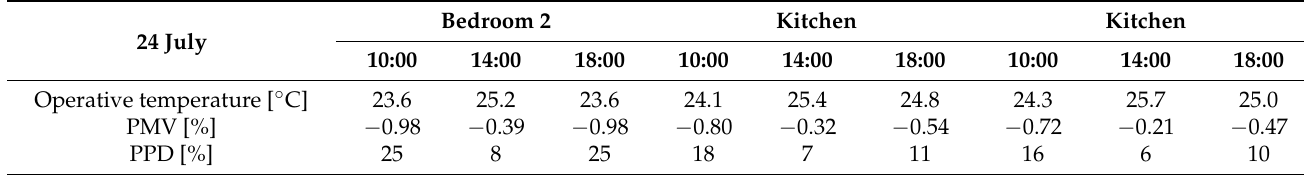
Table 9. PMV and PPD values calculated on 24